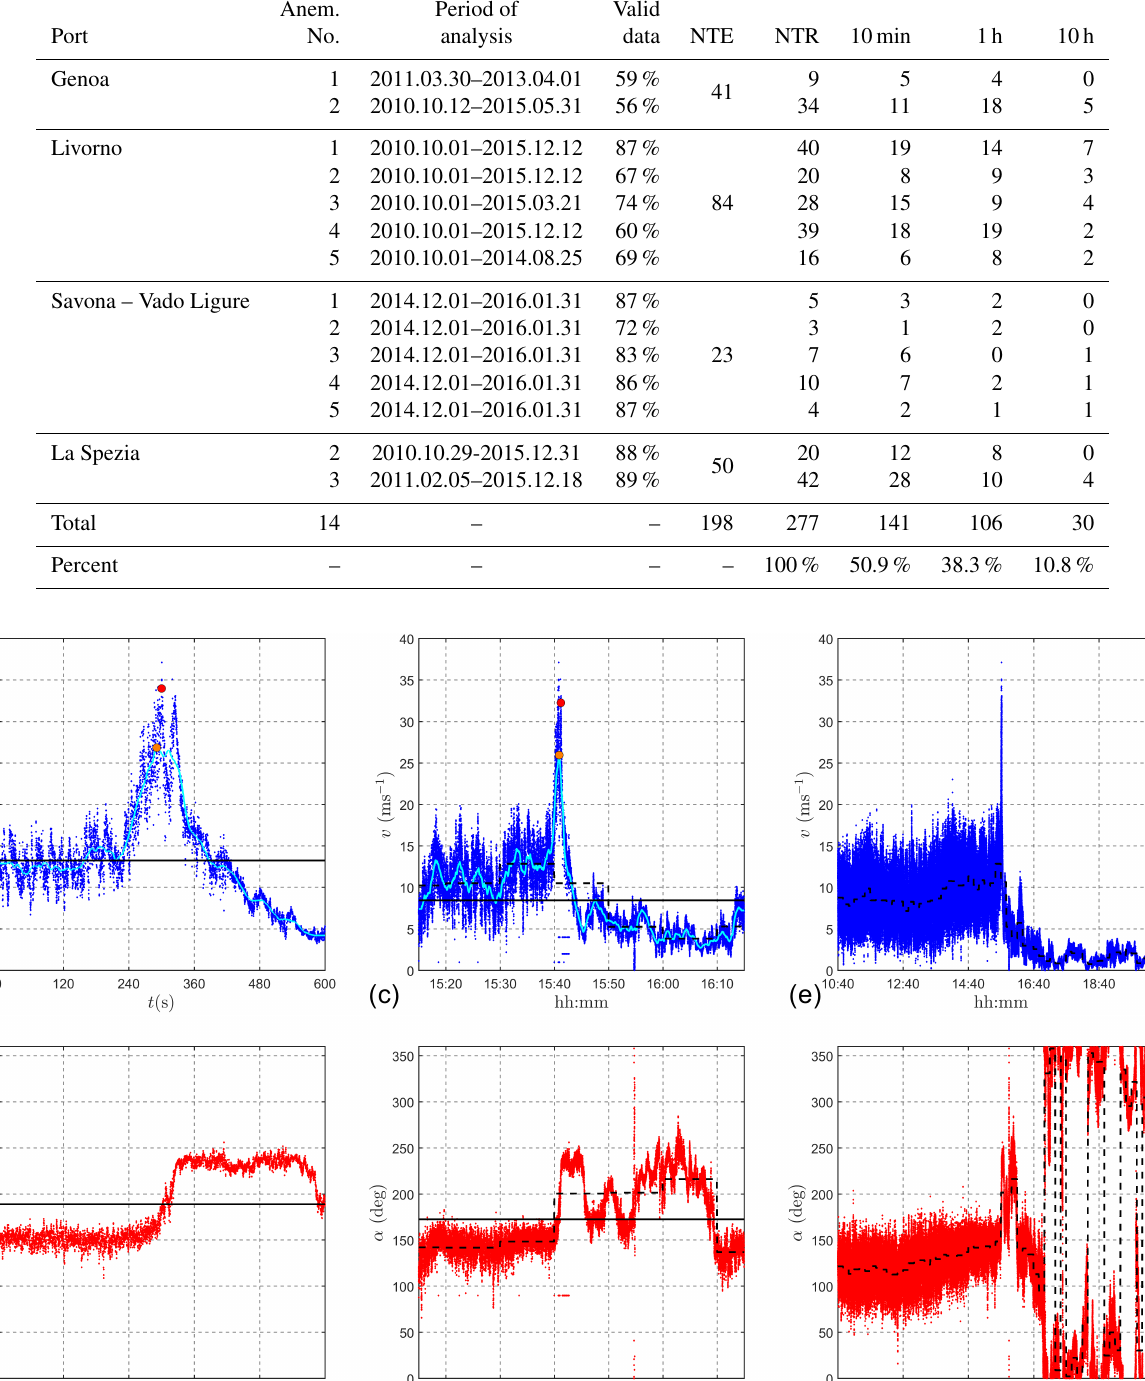
Table 2. Number of thunderstorm events and records examined. Date format is yyyy.mm.dd.